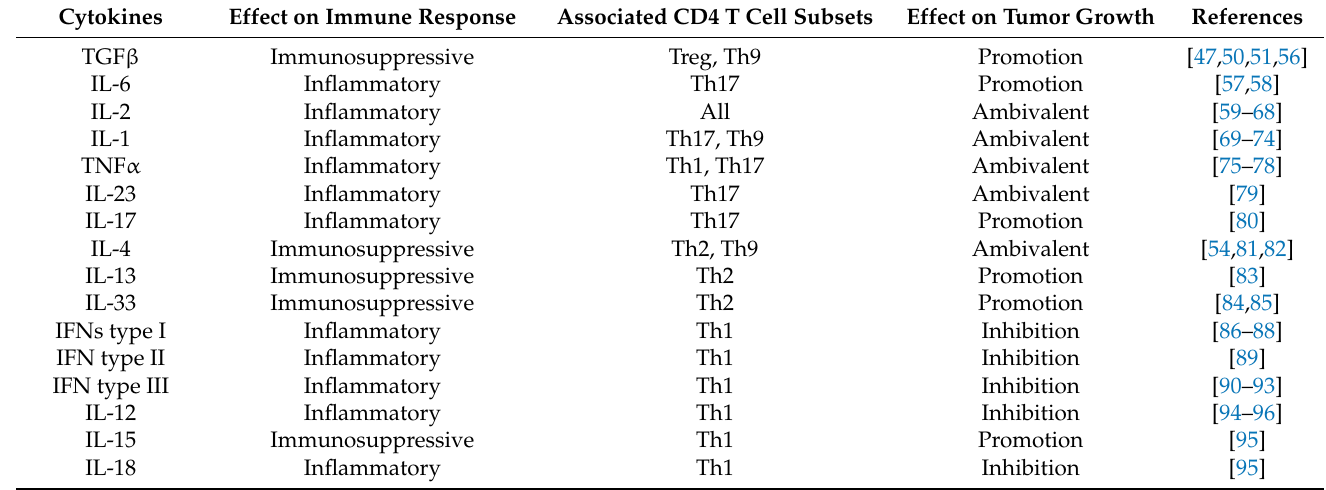
Table 1. Effects of cytokines present in the tumor microenvironment on the immune response, CD4 T cells, and tumor growth. Cytokines